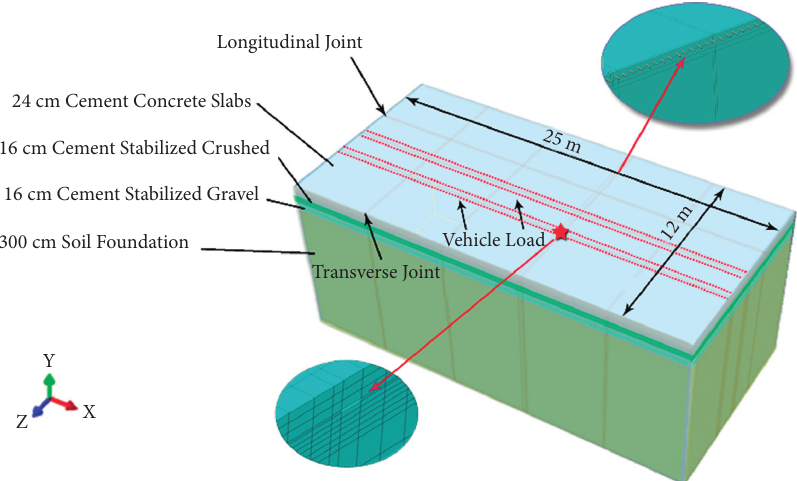
Figure 1: Finite element model of concrete pavement structure. Table 1: Material parameters of the 3DFEM